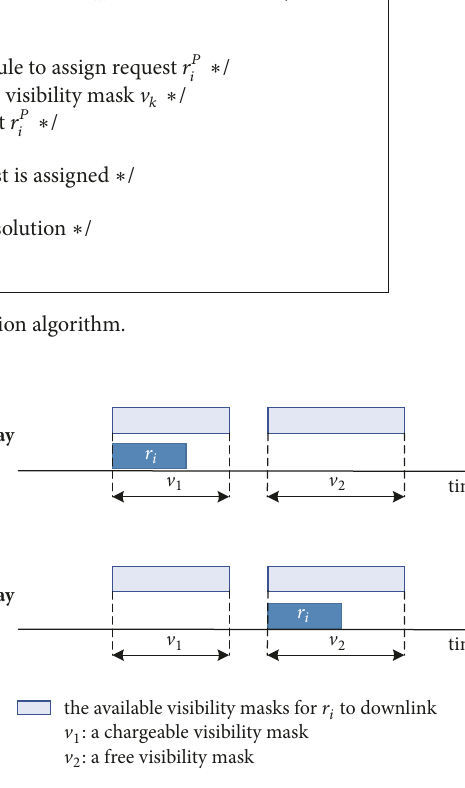
Figure 1: The case that using the delay rule can improve the